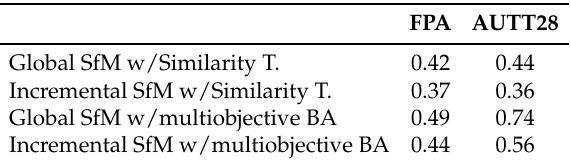
Table 1. Final RMS re-projection error (in pixels) achieved for the reconstructions of the FPA and AUTT28 models using all four strategies.